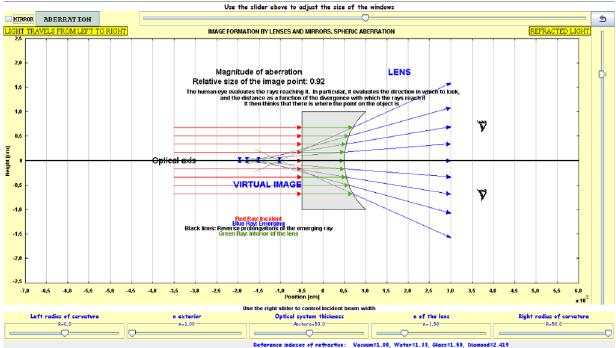
FIG. 3 (color online). View of the schematic JAVA environment developed to illustrate image formation by lenses and